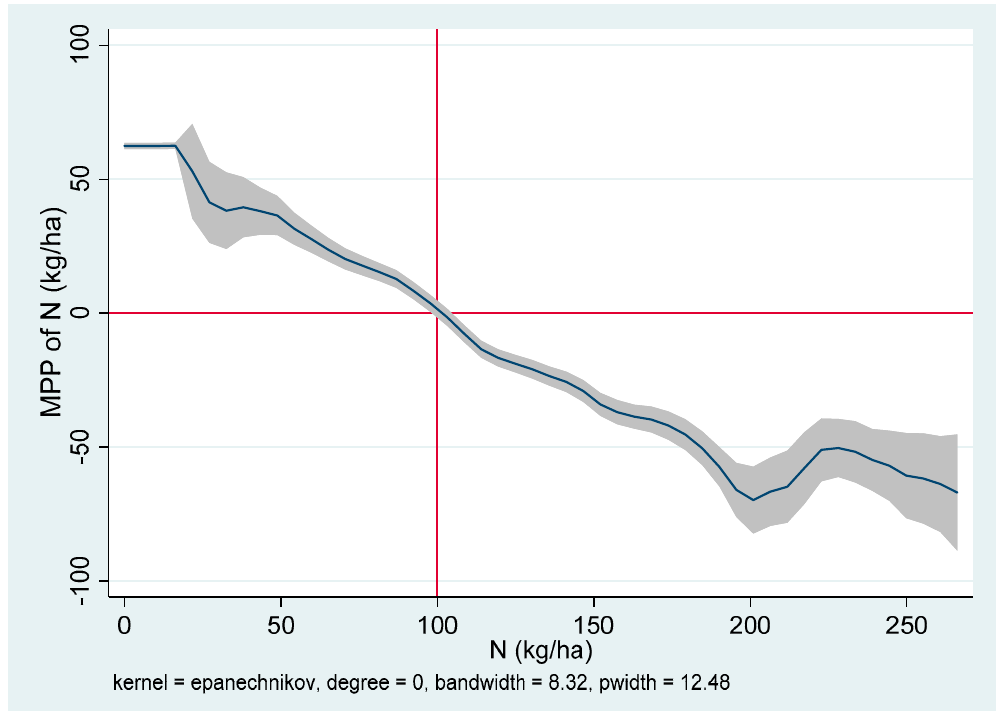
Figure 5. Marginal physical product of N ( MPP N ) at the mean level in Ha Noi, Vietnam.